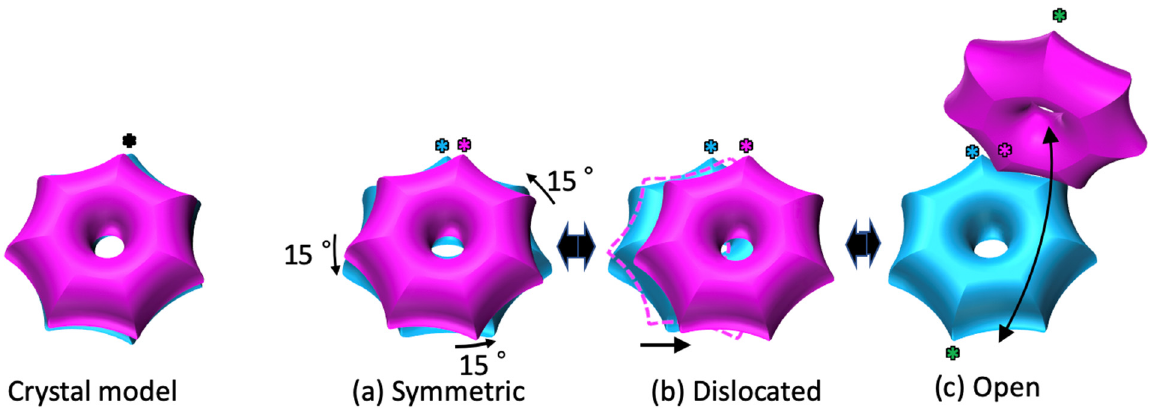
Figure 4. Structural fluctuation model of the α 7 homo-tetradecamer in solution. The symmetric-type cryo-EM model ( a ) shows a twist of 15° Å and a separation of 3 Å between the two rings, compared to the crystallographic model (left panel). In the dislocated-type cryo-EM model ( b ), one ring further rotates and slides while retaining the interaction area on one side of the ring, resulting in an offset of 11 Å between the two rings. In the open-type cryo-EM model ( c ), the two rings open while retaining the interaction area on one side of the ring, resulting in a twisted, cooked clam-like structure. The helix–helix interaction areas are labeled by asterisks.